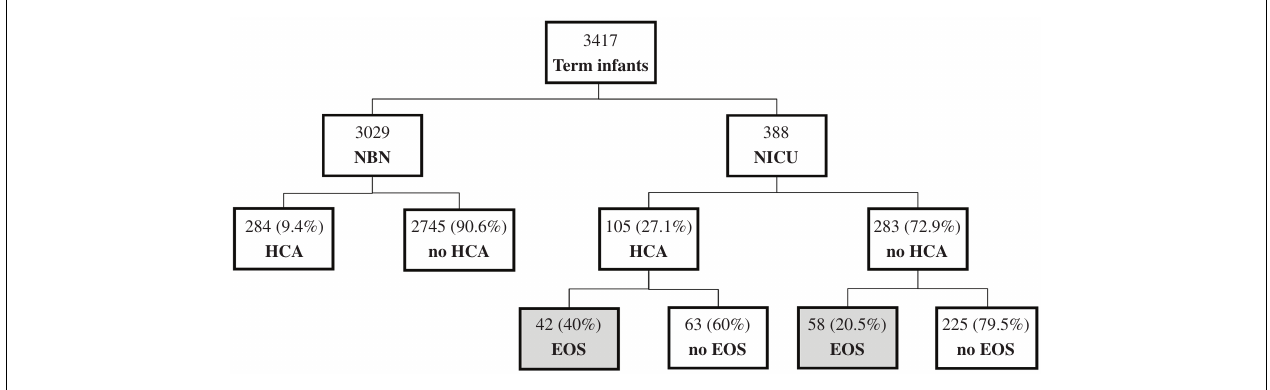
to the NICU for suspected sepsis, HCA was noted in 105 infants (27.1%).The incidence of EOCS in infants admitted to the NICU with suspected EOCS was higher in HCA group vs. no HCA group (40 vs. 20.5%, P <